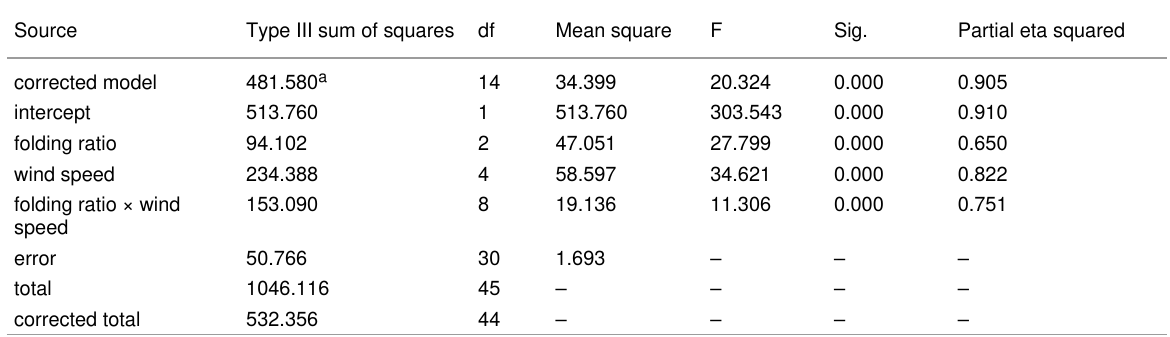
Table 3: Tests of between-subjects